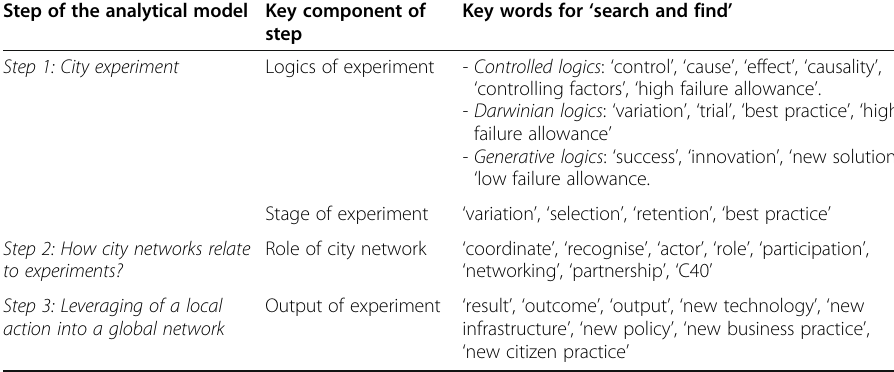
Table 3 Key words used for content analysis of the Climate Positive Development Good Practice Guide Step of the analytical model Key component of Key words for ‘ search and find step